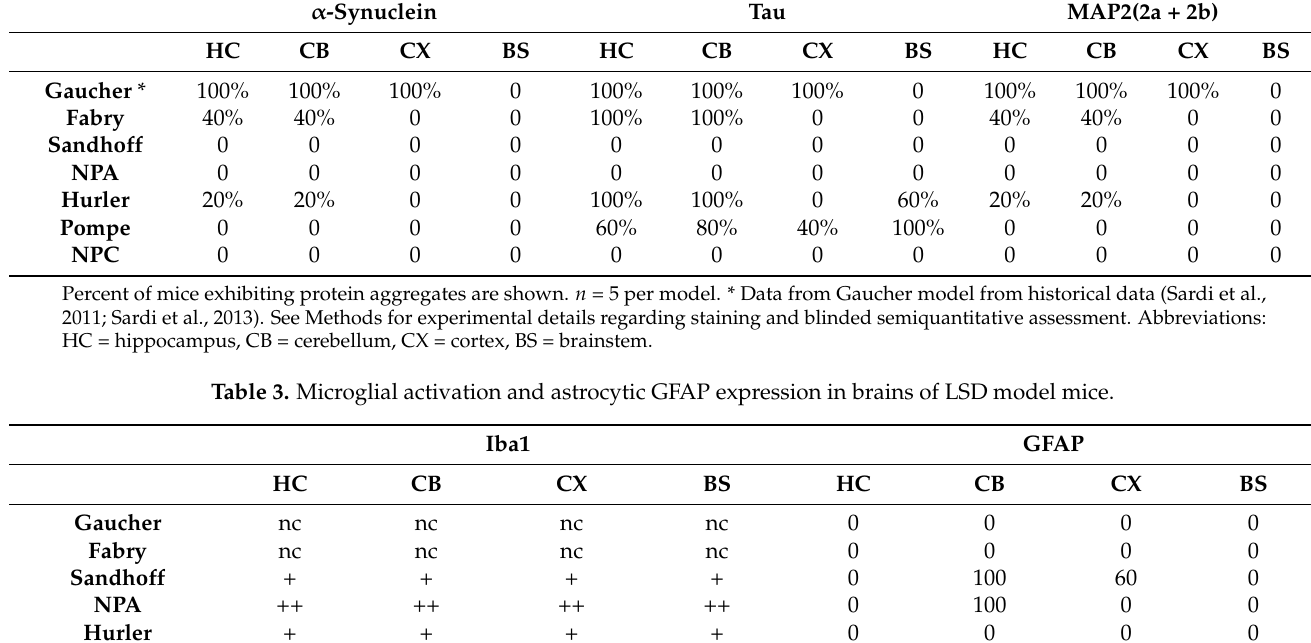
Table 2. Regional distribution of Lewy-body-like protein aggregates in brains of LSD model mice. α -Synuclein Tau MAP2(2a + 2b)